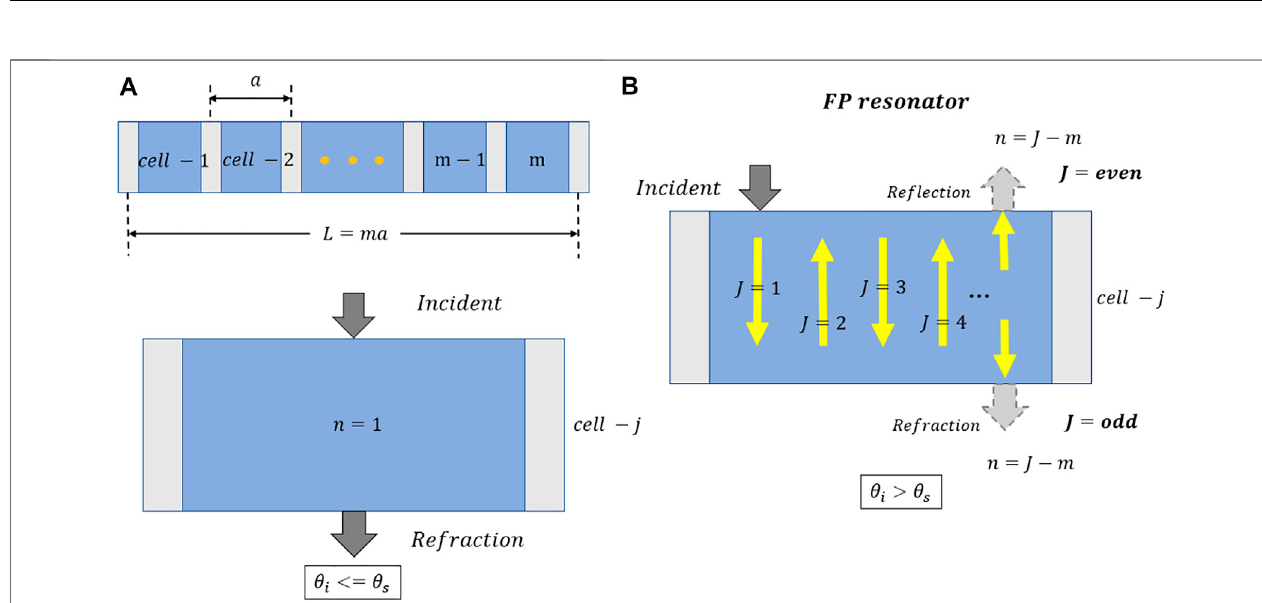
FIGURE 2 | (A) When the incident angle is less than or equal to the critical angle, the incident wave is transmitted normally from the unit cell; (B) When the incident angle is greater than the critical angle, the unit cell can be regarded as a Fabry-Perot resonator.